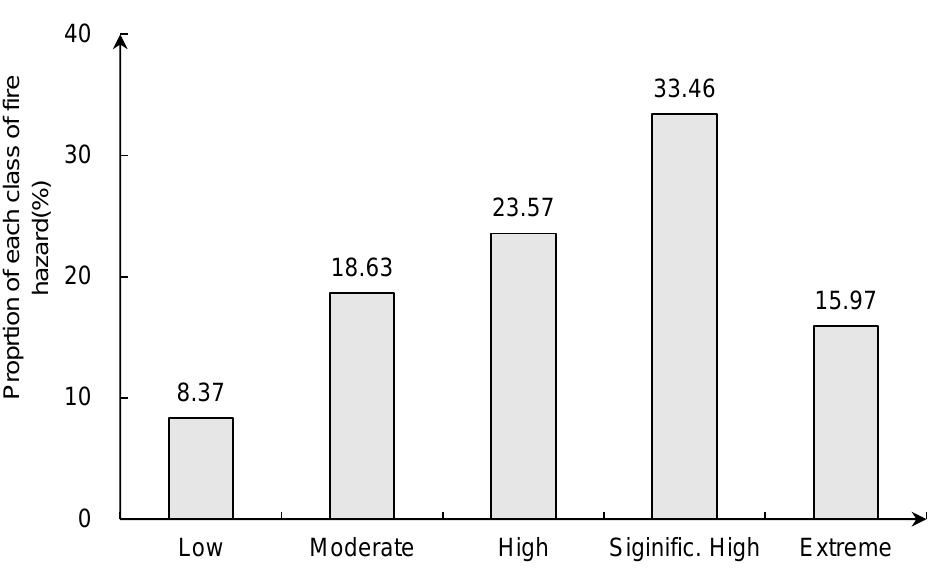
Figure 7. Representation of each hazard class of observed wildfire (%).